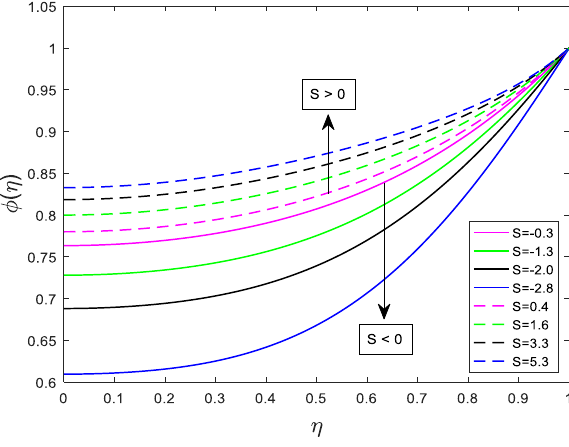
Figure 5: Effect of S on ϕ ( η ) for fixed β = 2.2, Ha = Ω T = N t = 0.1, Ω = Ec = 0.5, Pr = Sc = 0.7, and Kr = N = 0.5 C b